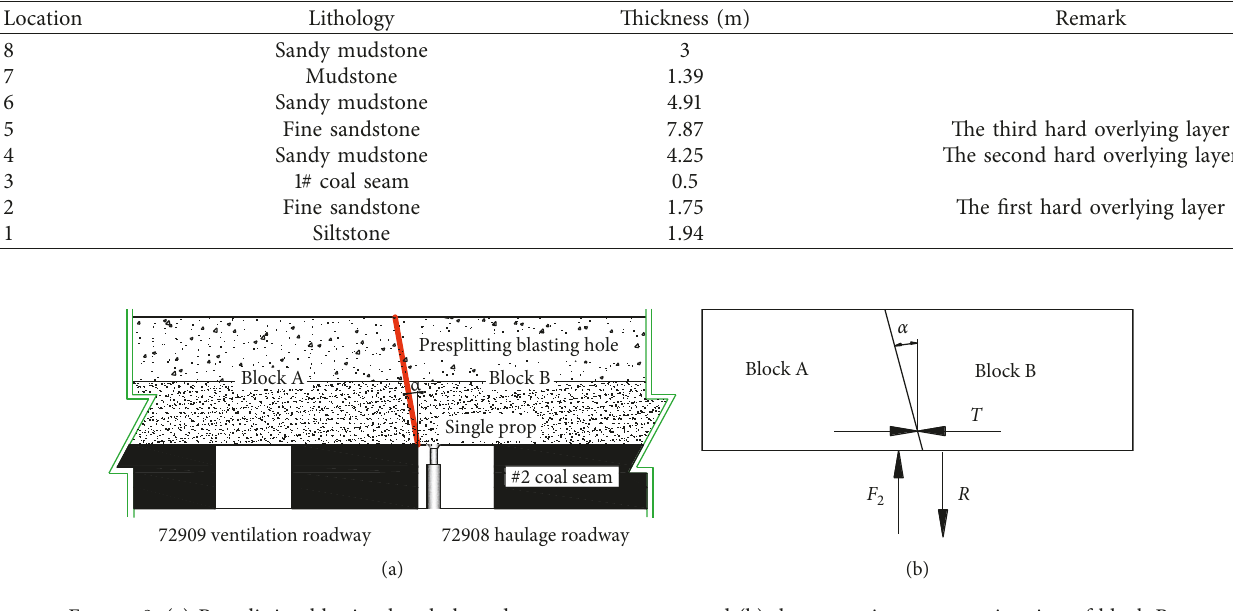
Figure 9: (a) Presplitting blasting borehole and temporary support and (b) the approximate stress situation of block